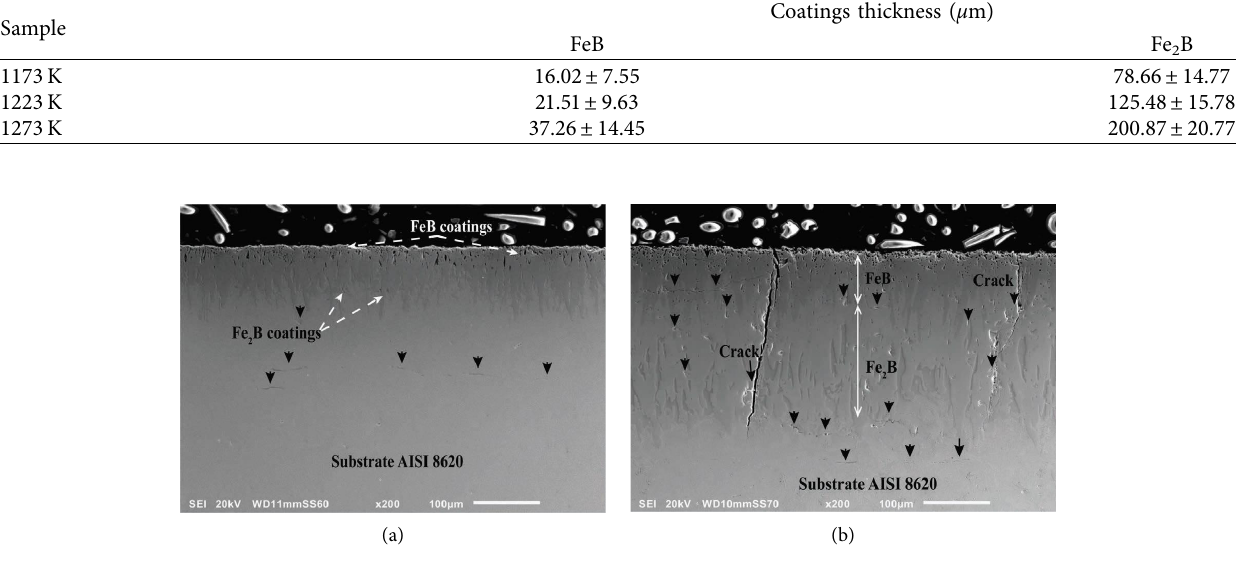
2 B coating, and (c) substrate (AISI 8620